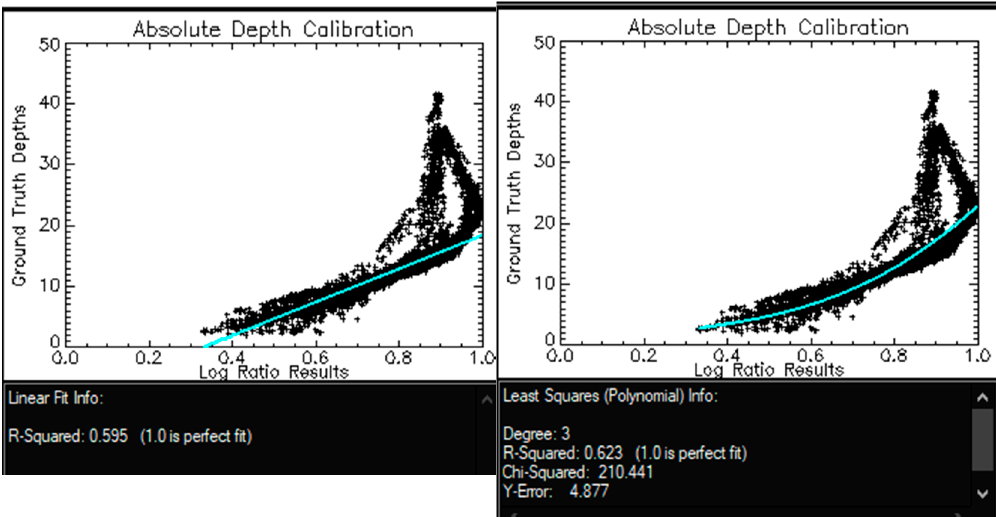
Figure A12. From 11 October 2016.